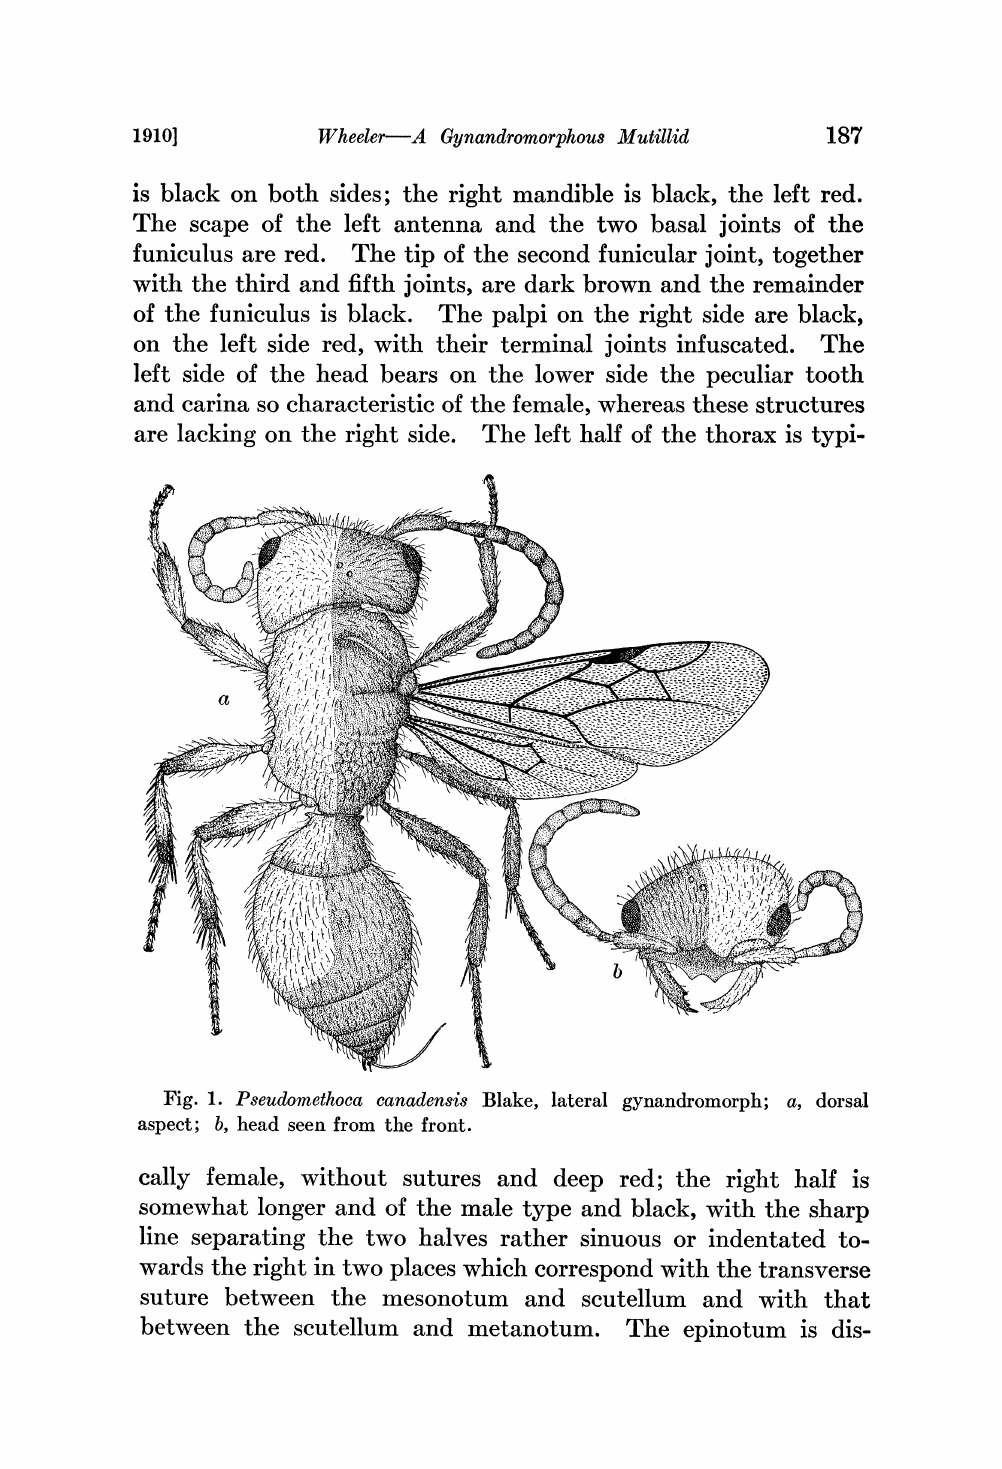
Fig. 1. Pseudomethoca canadensis Blake, lateral gynandromorph; a, dorsal aspect; b, head seen from the front. cally female, without sutures and deep red; the right half is somewhat longer and of the male type and black, with the sharp line separating the two halves rather sinuous or indentated to- wards the right in two places which correspond with the transverse suture between the mesonotum and scutellum and with that between the scutellum and